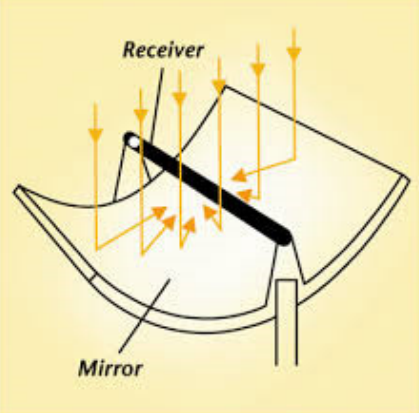
Fig. 1. Parabolic Trough